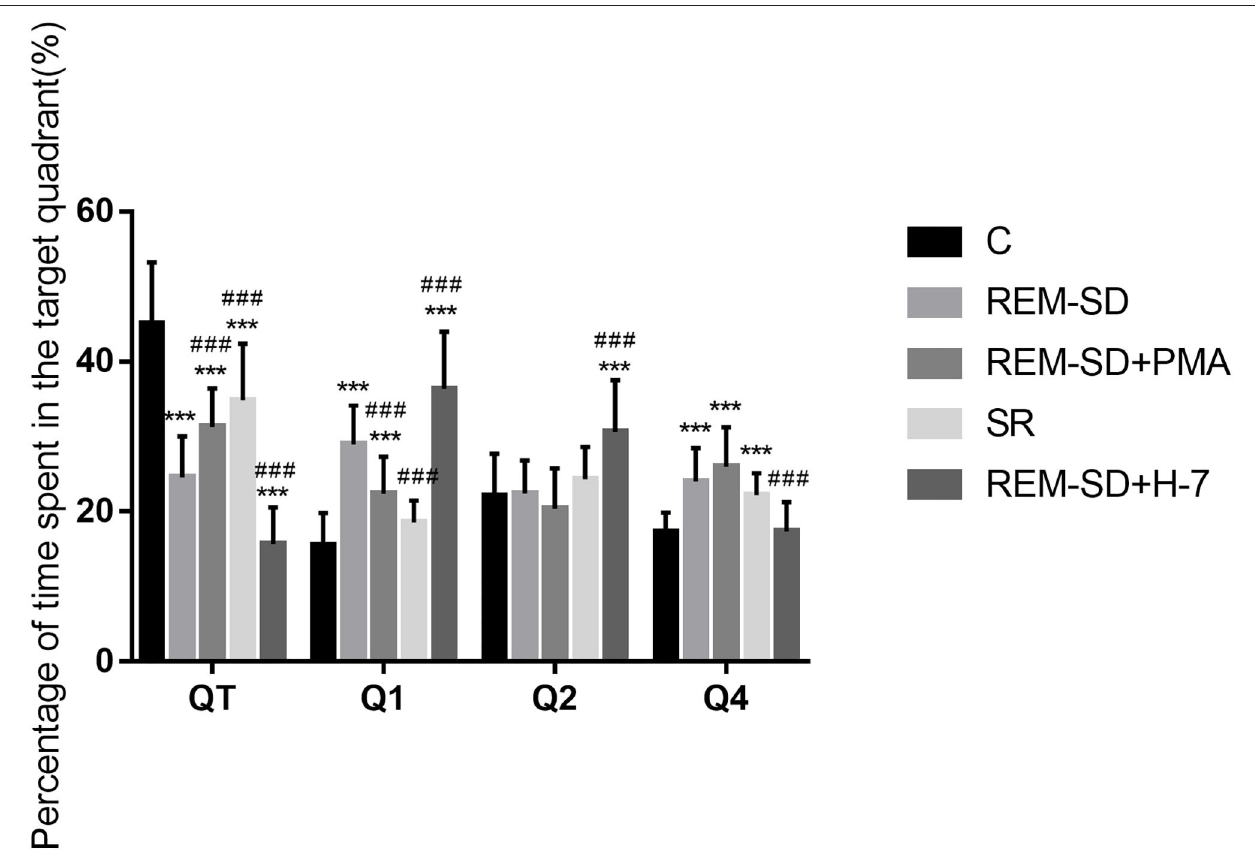
FIGURE 3 | The percentage of time spent in target quadrant for each group. Compared with the control group (C), the percentage of time spent searching the target quadrant (where the platform was placed) was significantly lower in the REM-SD, REM-SD + PMA, REM-SD + H-7, and SR groups. Compared with the REM-SD group, this time was significantly higher in the SR and REM-SD + PMA groups and lower in the REM-SD + H-7 group. *** ### means P < 0.001.